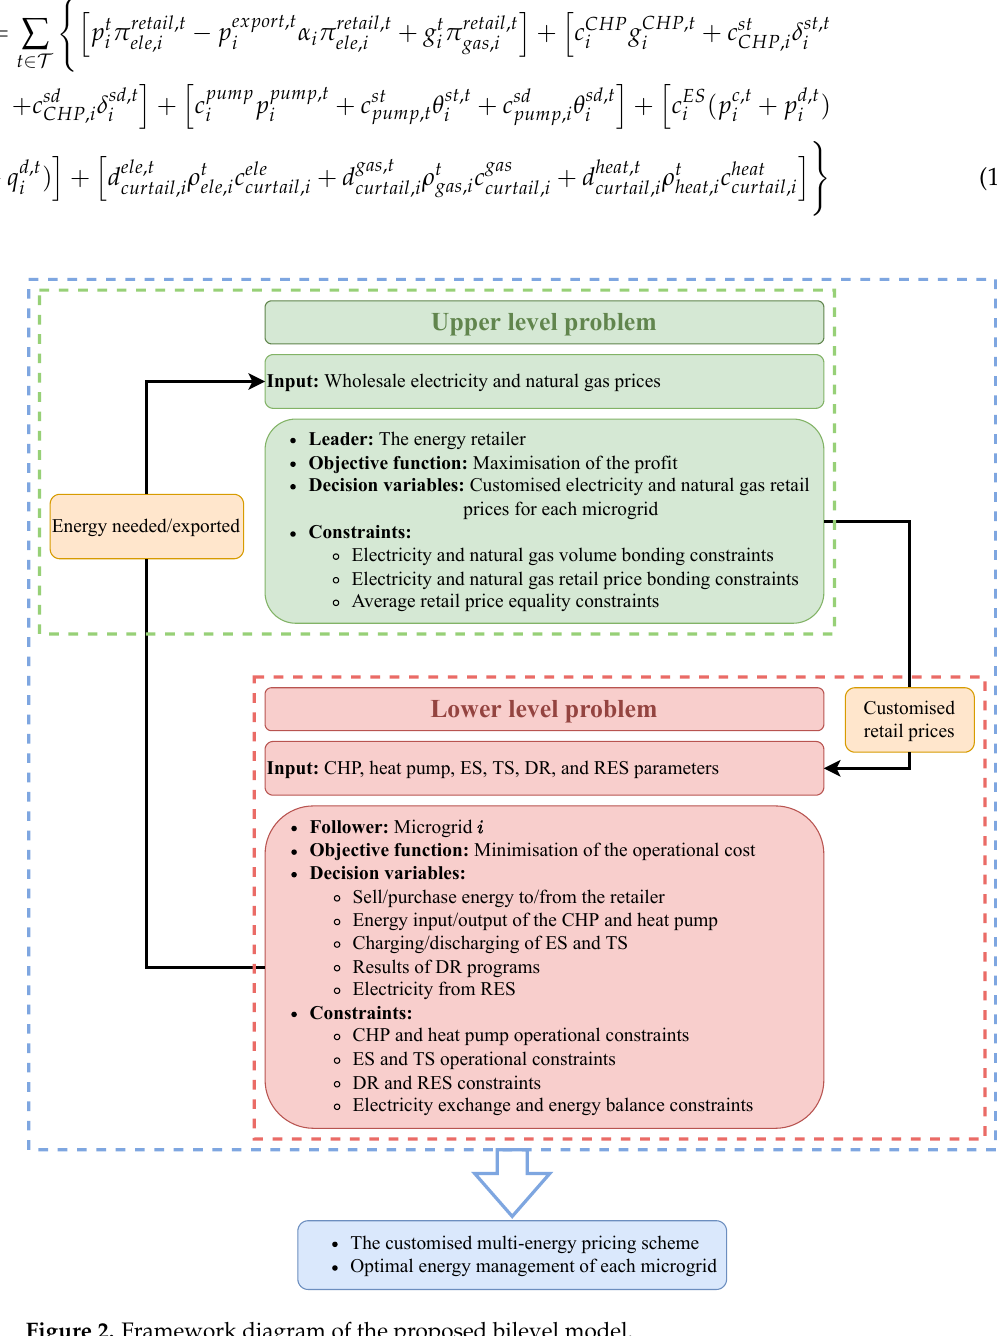
Figure 2. Framework diagram of the proposed bilevel